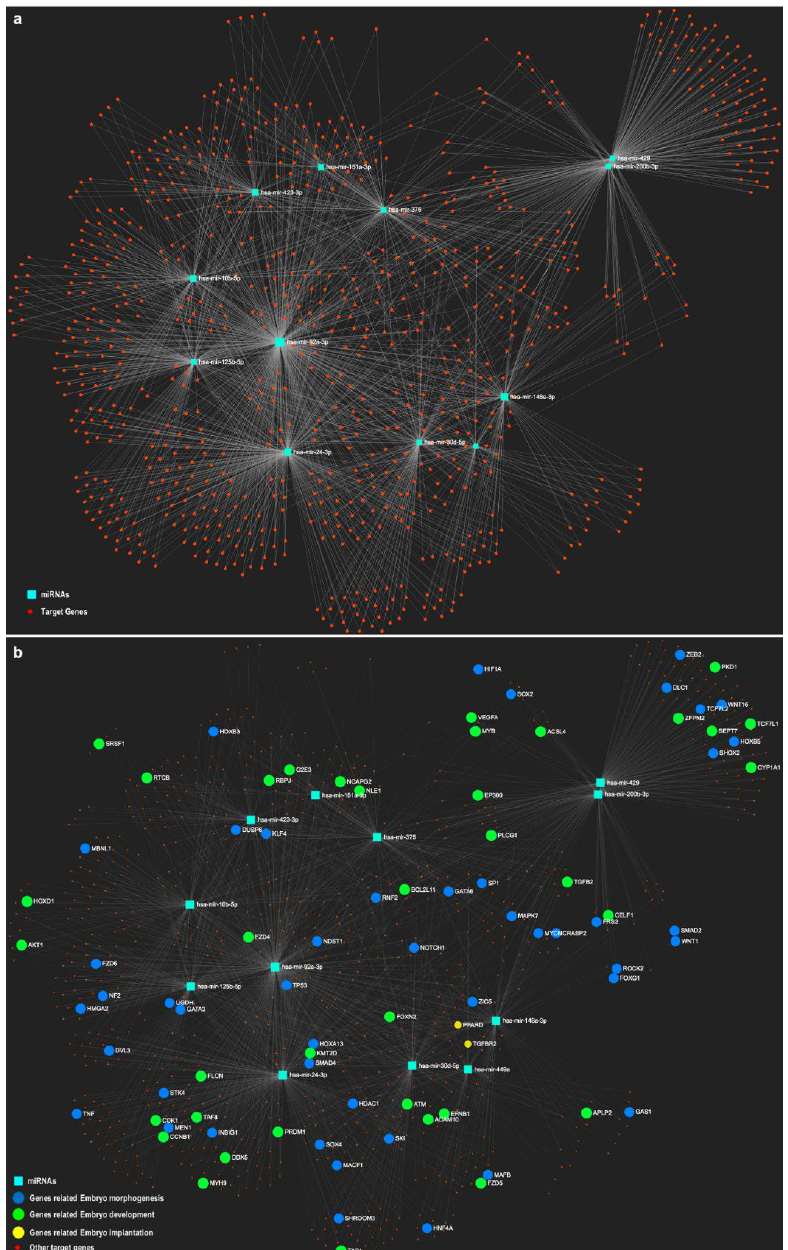
Figure 1. Networks of selected miRNAs identified in oviductal extracellular vesicles (oEVs) and potential target genes involved in embryo development. The miRNet online tool was used to represent selected miRNAs (13) (turquoise-blue nodes) based on differential expression and high abundance in oEVs at stage 1 of the bovine estrous cycle (recently ovulated follicle; days 1 – 4 post-ovulation) and potential target genes (red nodes) enriched in functional categories related to embryo development (green), embryo morphology (blue) and implantation (yellow) in a network. Since the miRNet online tool allows to choose the source/tissue for the list of miRNAs, network ( a ) represents 11 miRNAs contained in exosomes in the online tool database, with all target genes involved in embryo development. Network ( b ) represents 3 miRNAs contained in embryos in the online tool database, with all target genes involved in embryo development functions.